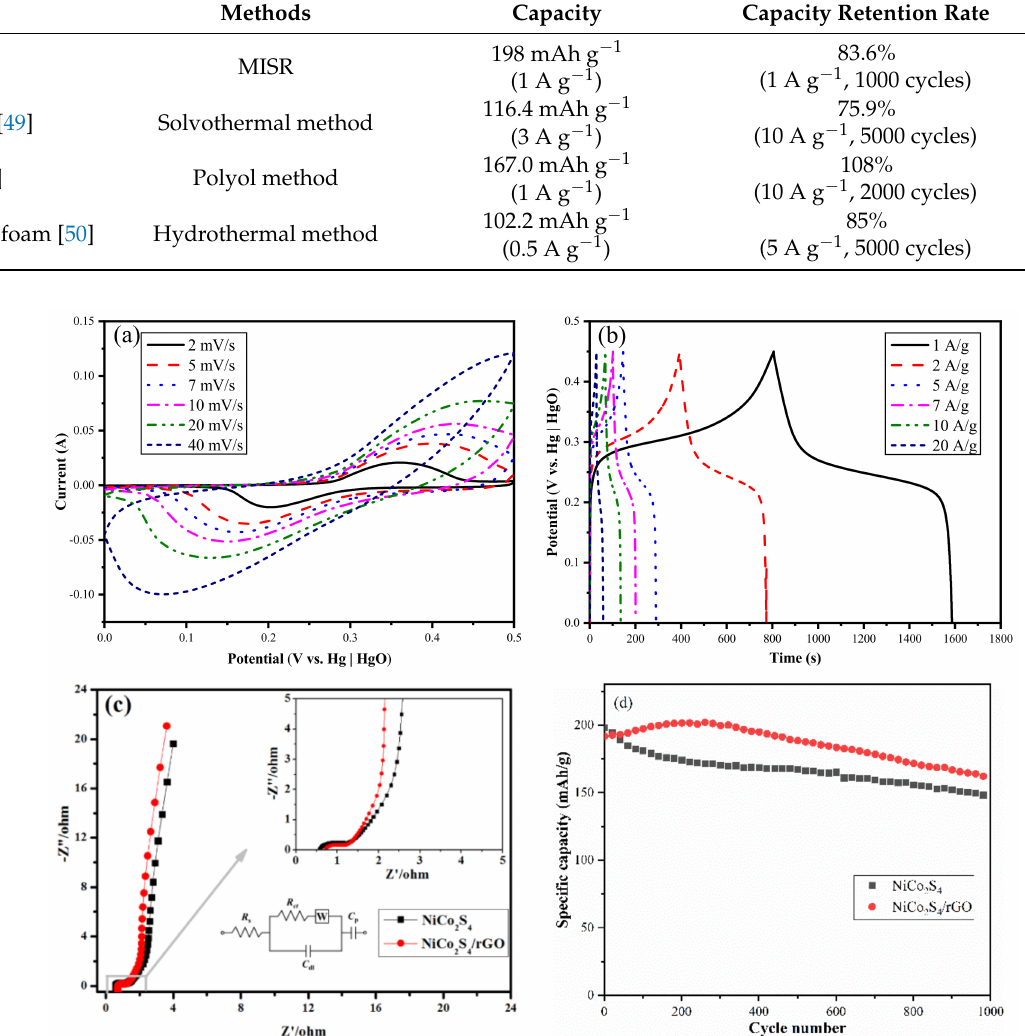
Table 1. Electrochemical comparison of NiCo-based sulfides synthesized by different methods.